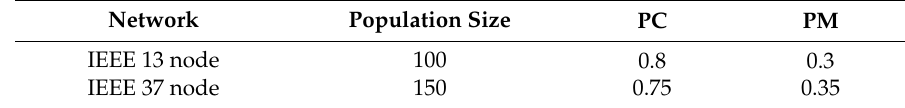
Table 1. Genetic algorithm’s parameters for optimization. PC, probability of crossover; PM, probability of